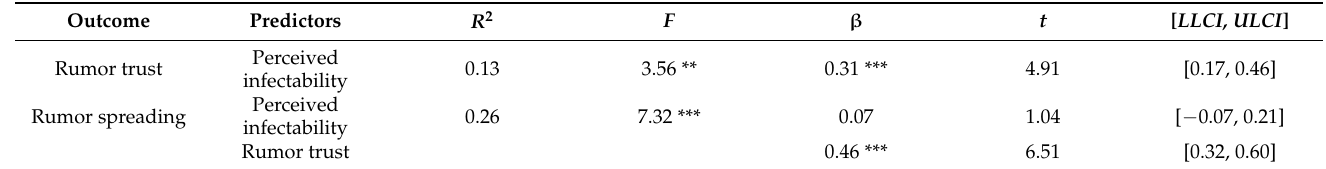
Table 4. Regression analysis of the mediation model in Study